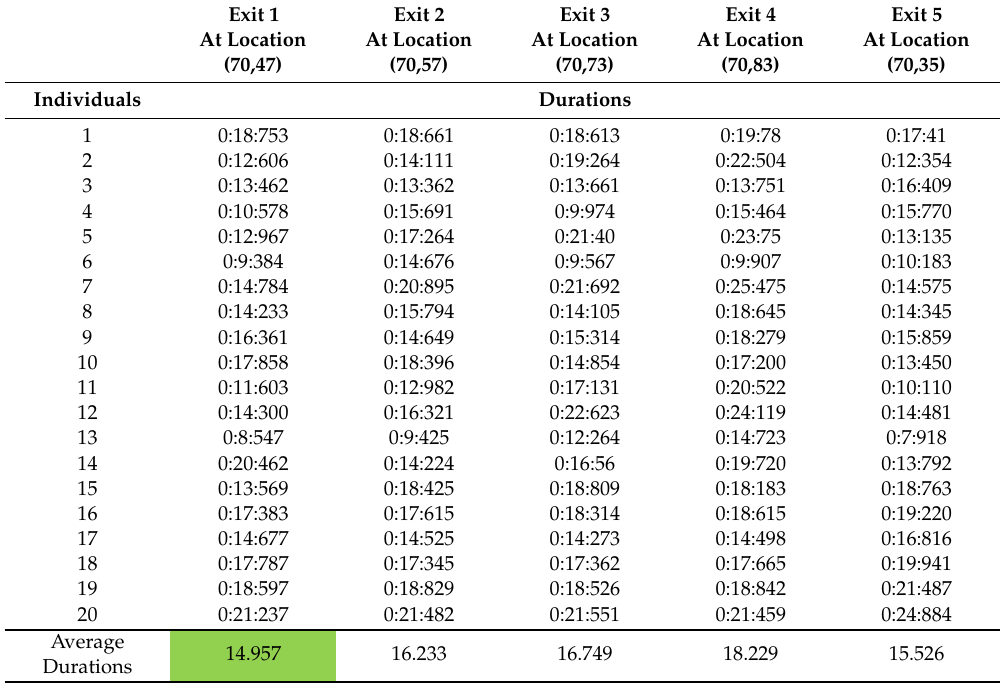
Table 5. Result of scenario #B for 20 nonfamiliar evacuees for 5 exit door locations.